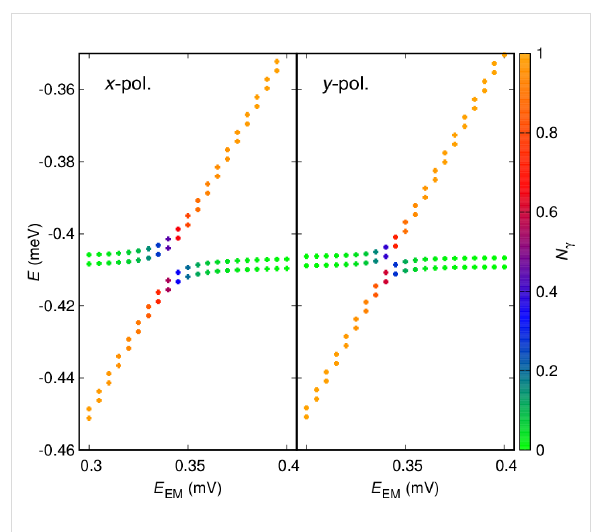
Figure 3: The energy of the two spin components of the lowest in energy one-electron states, mostly localized in the left dot (shallower) and the first photon replica of the corresponding states in the right dot (deeper) as the energy of the cavity photon E EM = is varied. V g = 0 mV. For V g = 1.6 mV the states are labeled with and see Figure 2. The mean photon content of the states is indi- cated by the color of the dots and defined by the color bar on the right side of the figure. (Left) x -polarized, and (right) y -polarized cavity photon field. B ext = 0.1 T, L x = 180 nm, = 2.0 meV, and g EM = 0.05